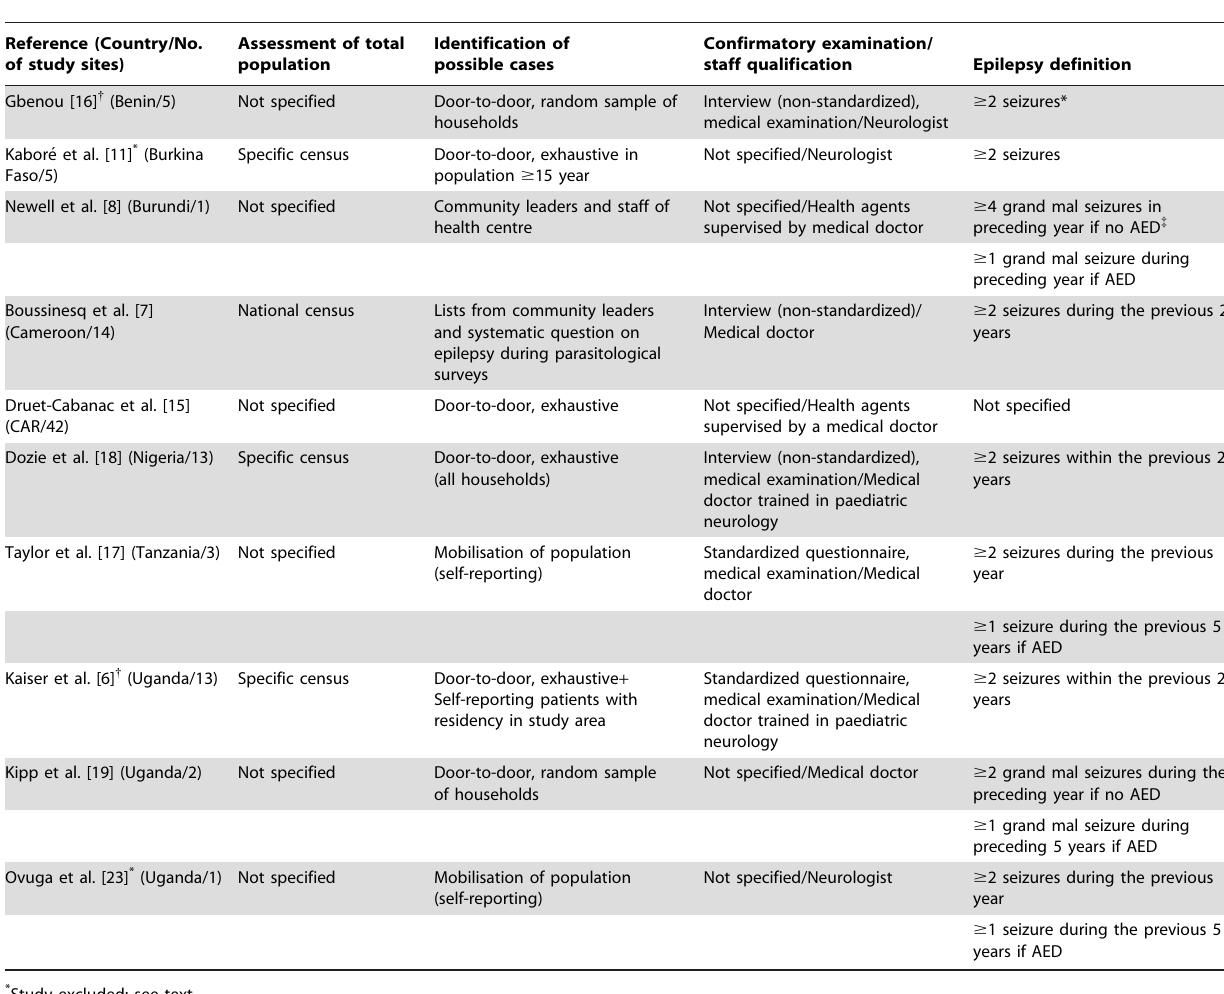
Table 2. Synopsis of neuro-epidemiological methodology used in studies on epilepsy prevalence in areas endemic for